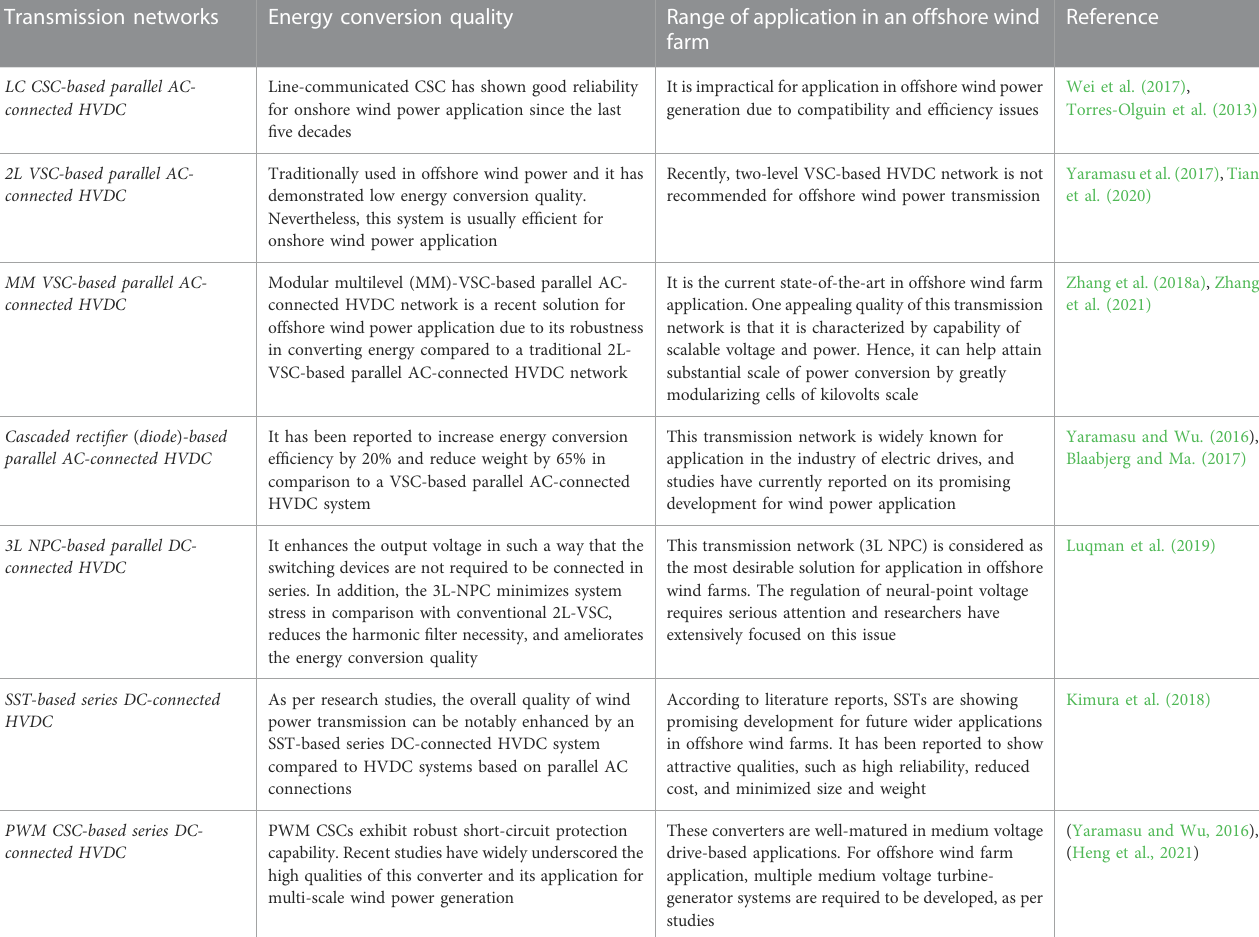
TABLE 4 Comparison of different converter – HVDC networks for offshore power transmission applications. Transmission